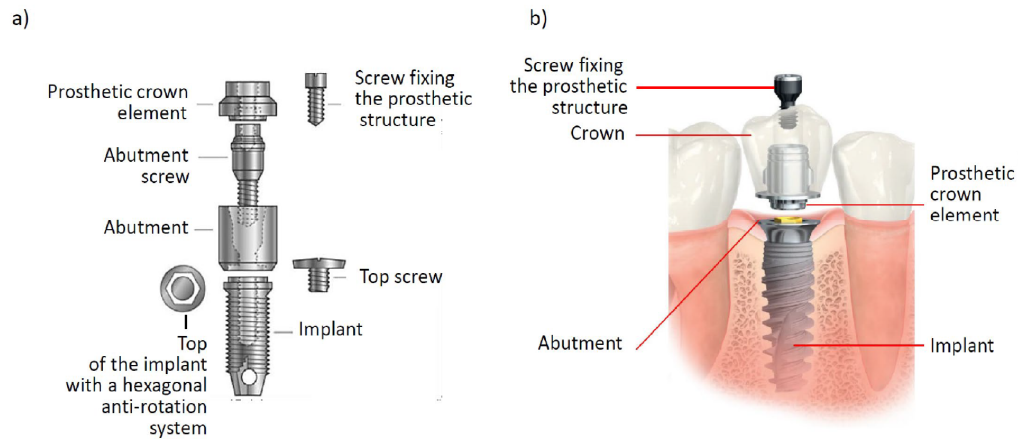
Figure 2. Examples of dental implants developed according to the Braenemark concept. ( a ) arrangement of the main elements; ( b ) view after installation in the bone.